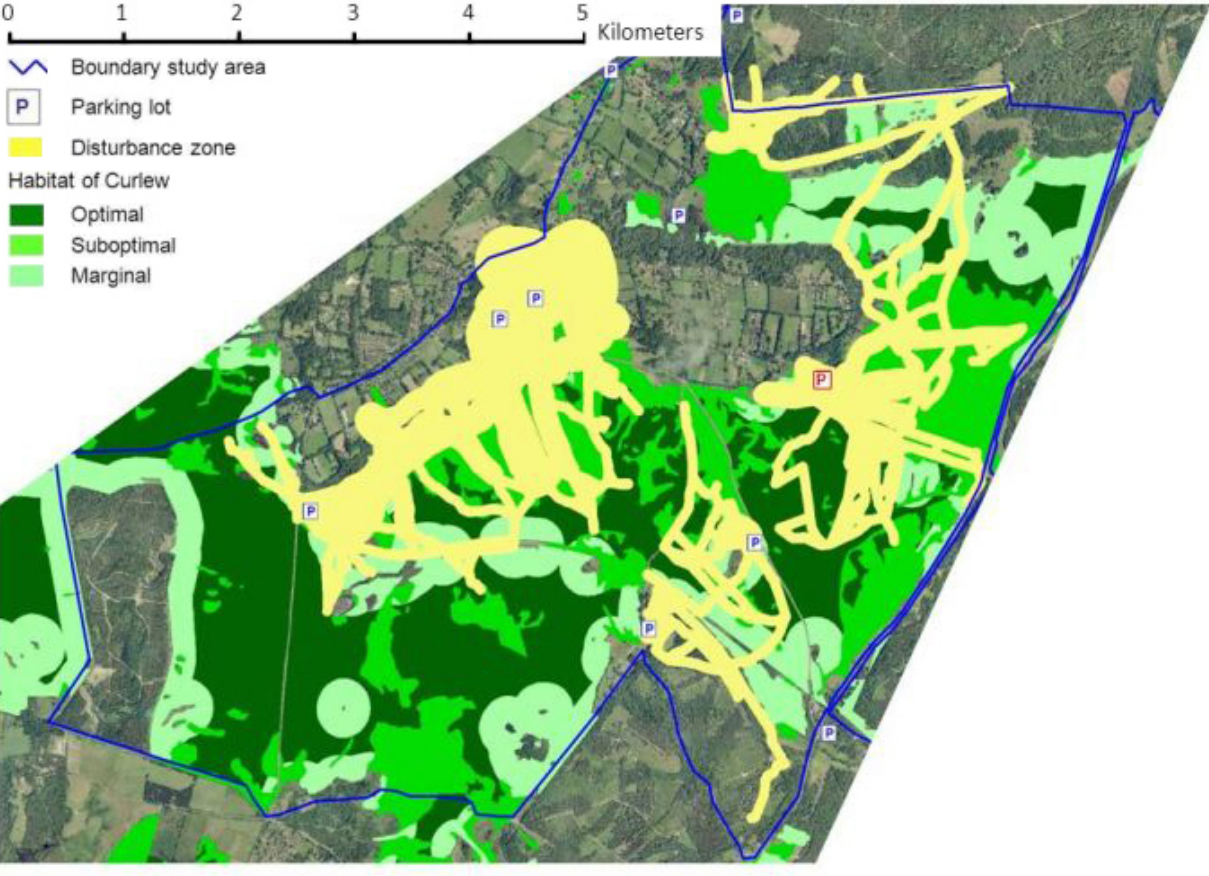
Fig. 4. Map of the disturbance zones of visitors overlain on the habitat map of wader species, overlain on an aerial photograph. The easternmost parking lot is shown in red (‘P’). Based on local maps consisting of vegetation structure and slope, the habitat was classified as optimal, suboptimal, and marginal. In optimal habitat wader species can reach high densities and in marginal habitat low